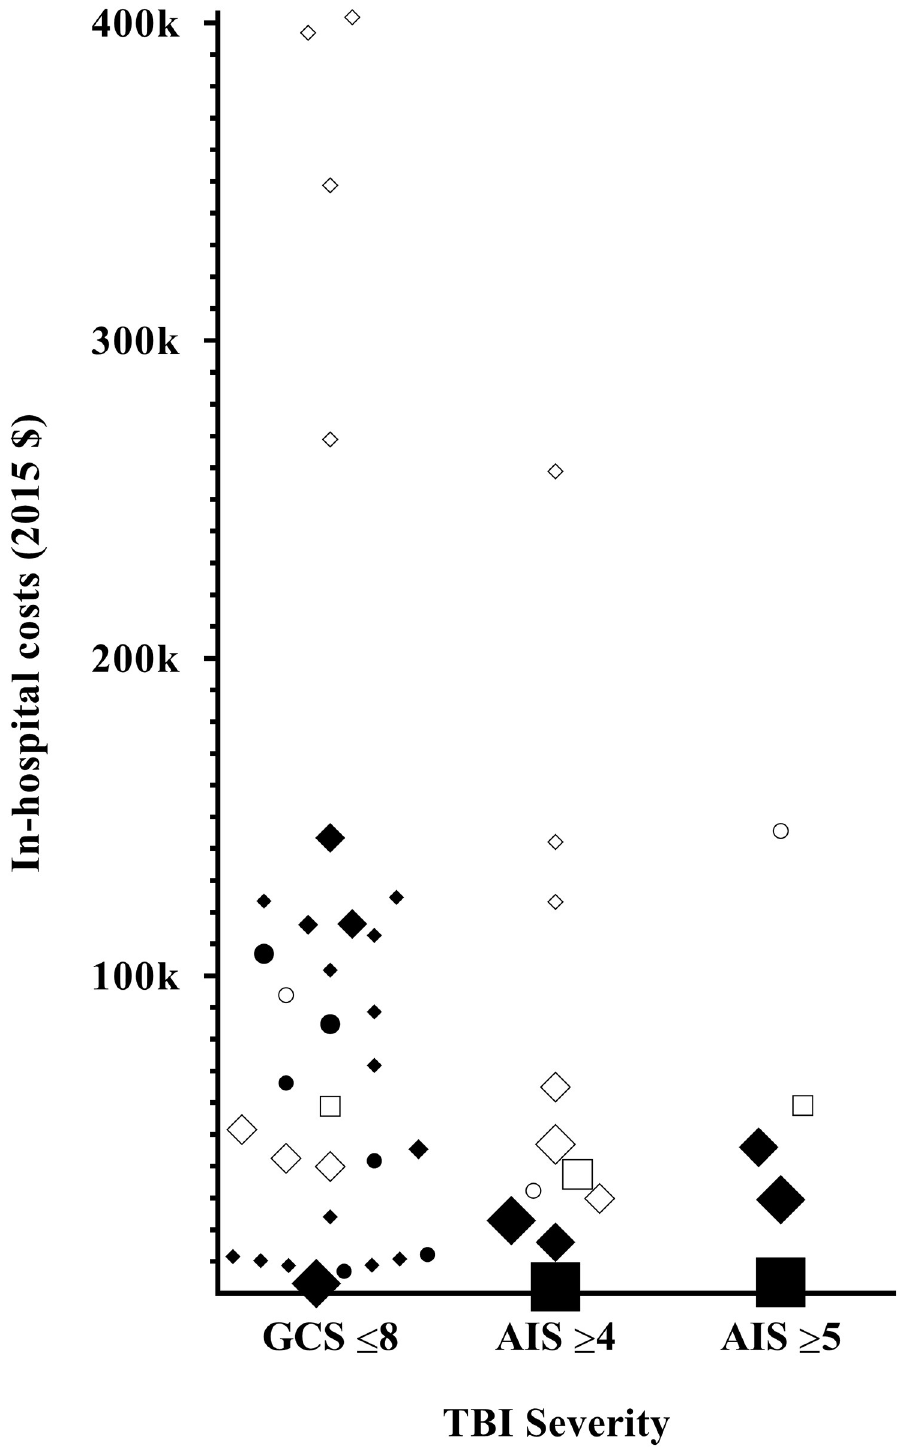
Fig 2. In-hospital costs and in-hospital charges of a patient with s-TBI. Black indicators represent in hospital costs, while white indicators represent in-hospital charges. A bigger indicator size, represents a bigger study cohort size. ● � : Paediatric ♦ ^ : Adult ■ □ :